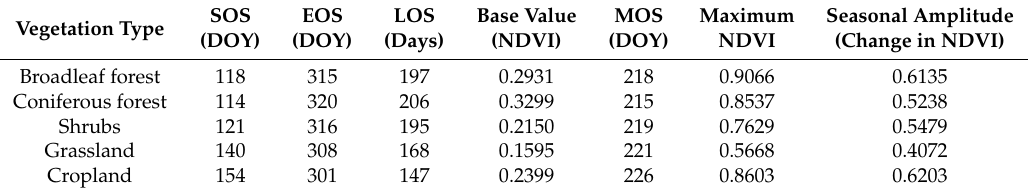
Table 5. Comparison of the values of the seven vegetation phenological parameters for the five vegetation types. SOS, start of the season. EOS, end of the season. DOY, day of year.